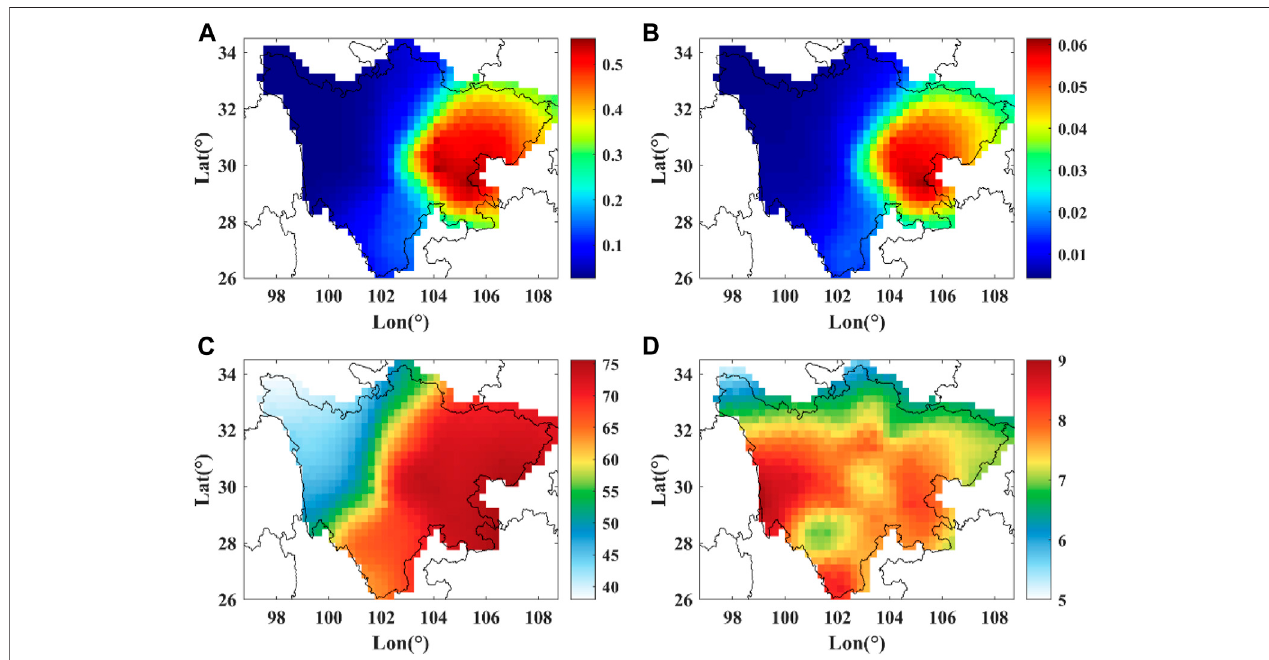
FIGURE 2 | Spatial distribution of (A) sulfate AOD, (B) BC AOD, (C) sulfate AOD ratio (in %), and (D) BC AOD ratio (in %) in Sichuan during warm season.